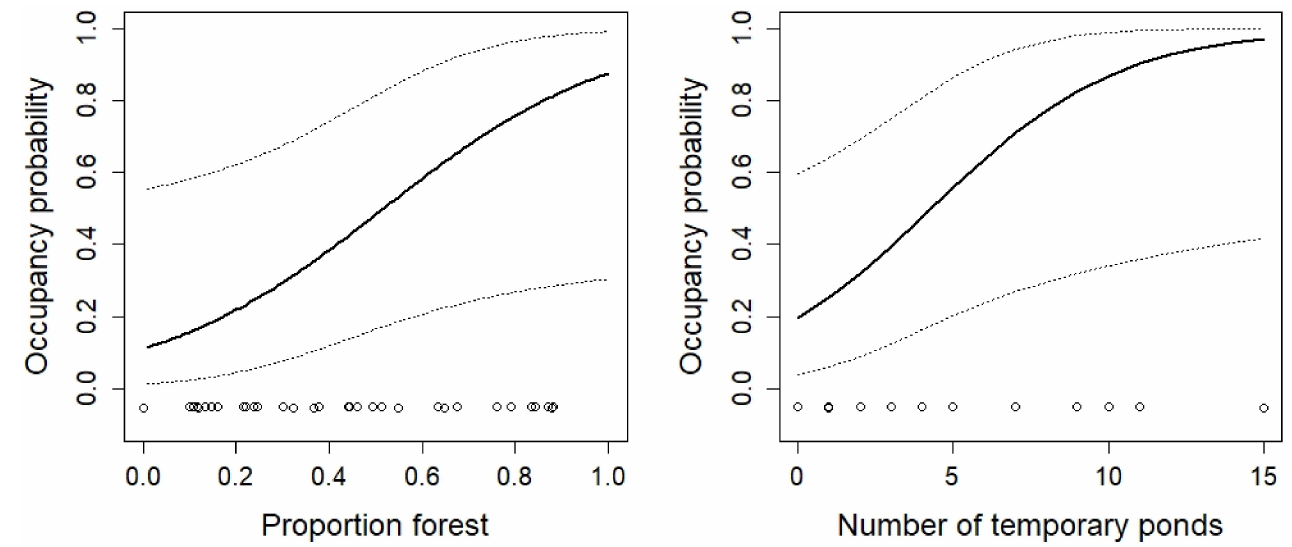
Figure 11. The effect of the proportion of forest and the number of temporary ponds on the occupancy probability of Triturus carnifex . For additional explanations, see the caption of Figure 2.